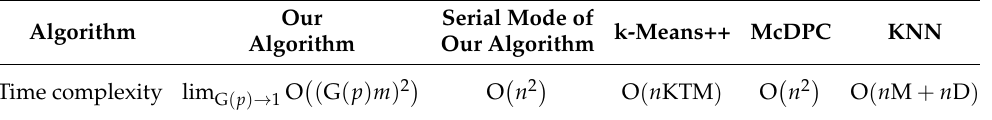
Table 2. Time complexity statistics of various algorithms. T is the number of iterations, M is the characteristic number of elements, m is the number of samples of Block ( i ) , K is the number of cluster centers, and D is the nearest neighbor